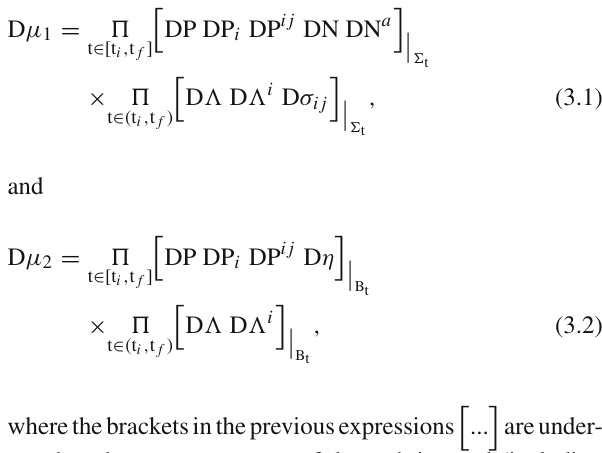
Table 1 Integrated vs fixed degrees of freedom over each region. Notice that the number of integrated and fixed degrees of freedom add up to ten over each region